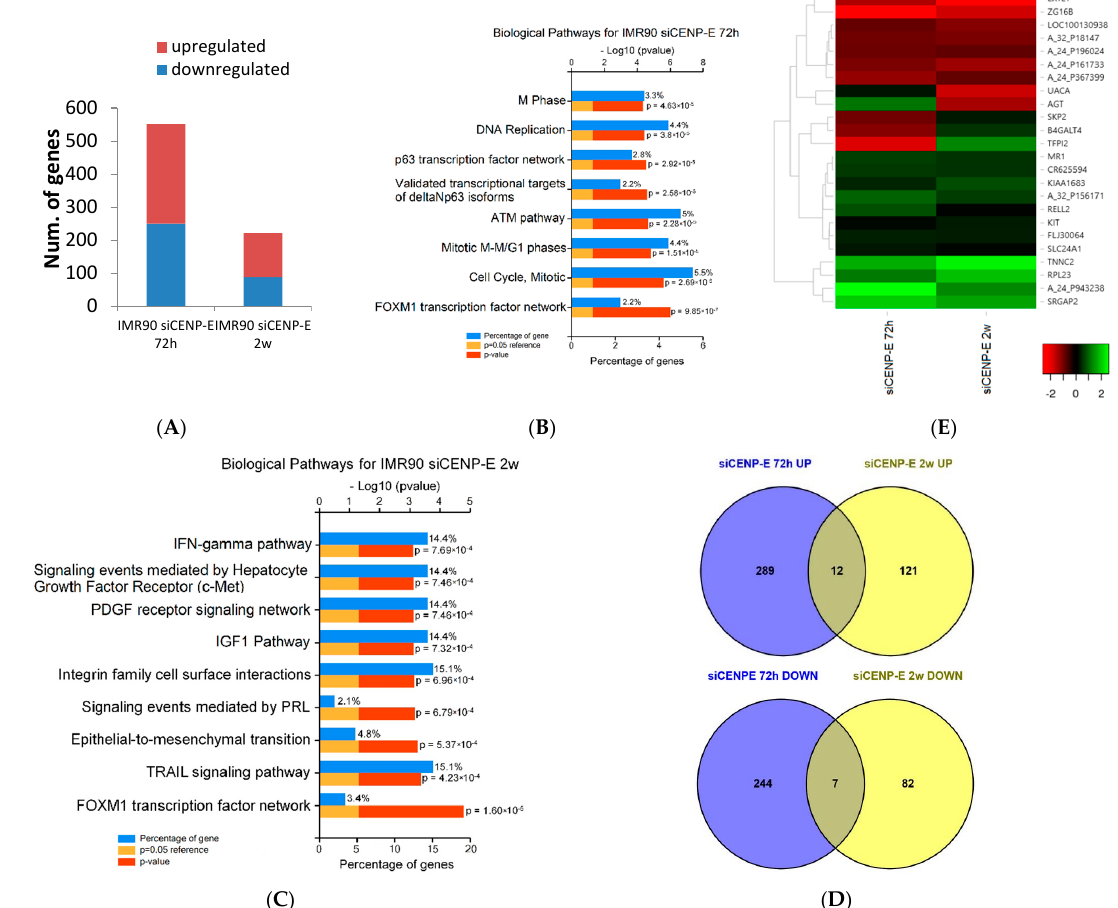
Figure 1. Genome-wide microarray analysis. Comprehensive gene expression analysis at early (72 h) and late (2 w) timepoints after siRNAs (siCENP-E) transfection of IMR90 cells compared to IMR90 control cells (siGFP). ( A ) Histogram showing number of genes up or down regulated in each sample. (FC ± 1.4, p -value cutoff ≤ 0.05) ( B , C ) Biological pathways for DEGs. x -axis represents the percentages of genes or − log10 values ( p -value); y -axis represents the Biological pathways significantly enriched using the FunRich bioinformatics tool. ( D ) Venn diagram set out the number of common up- ( top ) and down- ( bottom ) regulated DEGs found in the two samples. ( E ) Heat map displaying expression levels of significantly common DEGs in trasfected IMR90 cells.